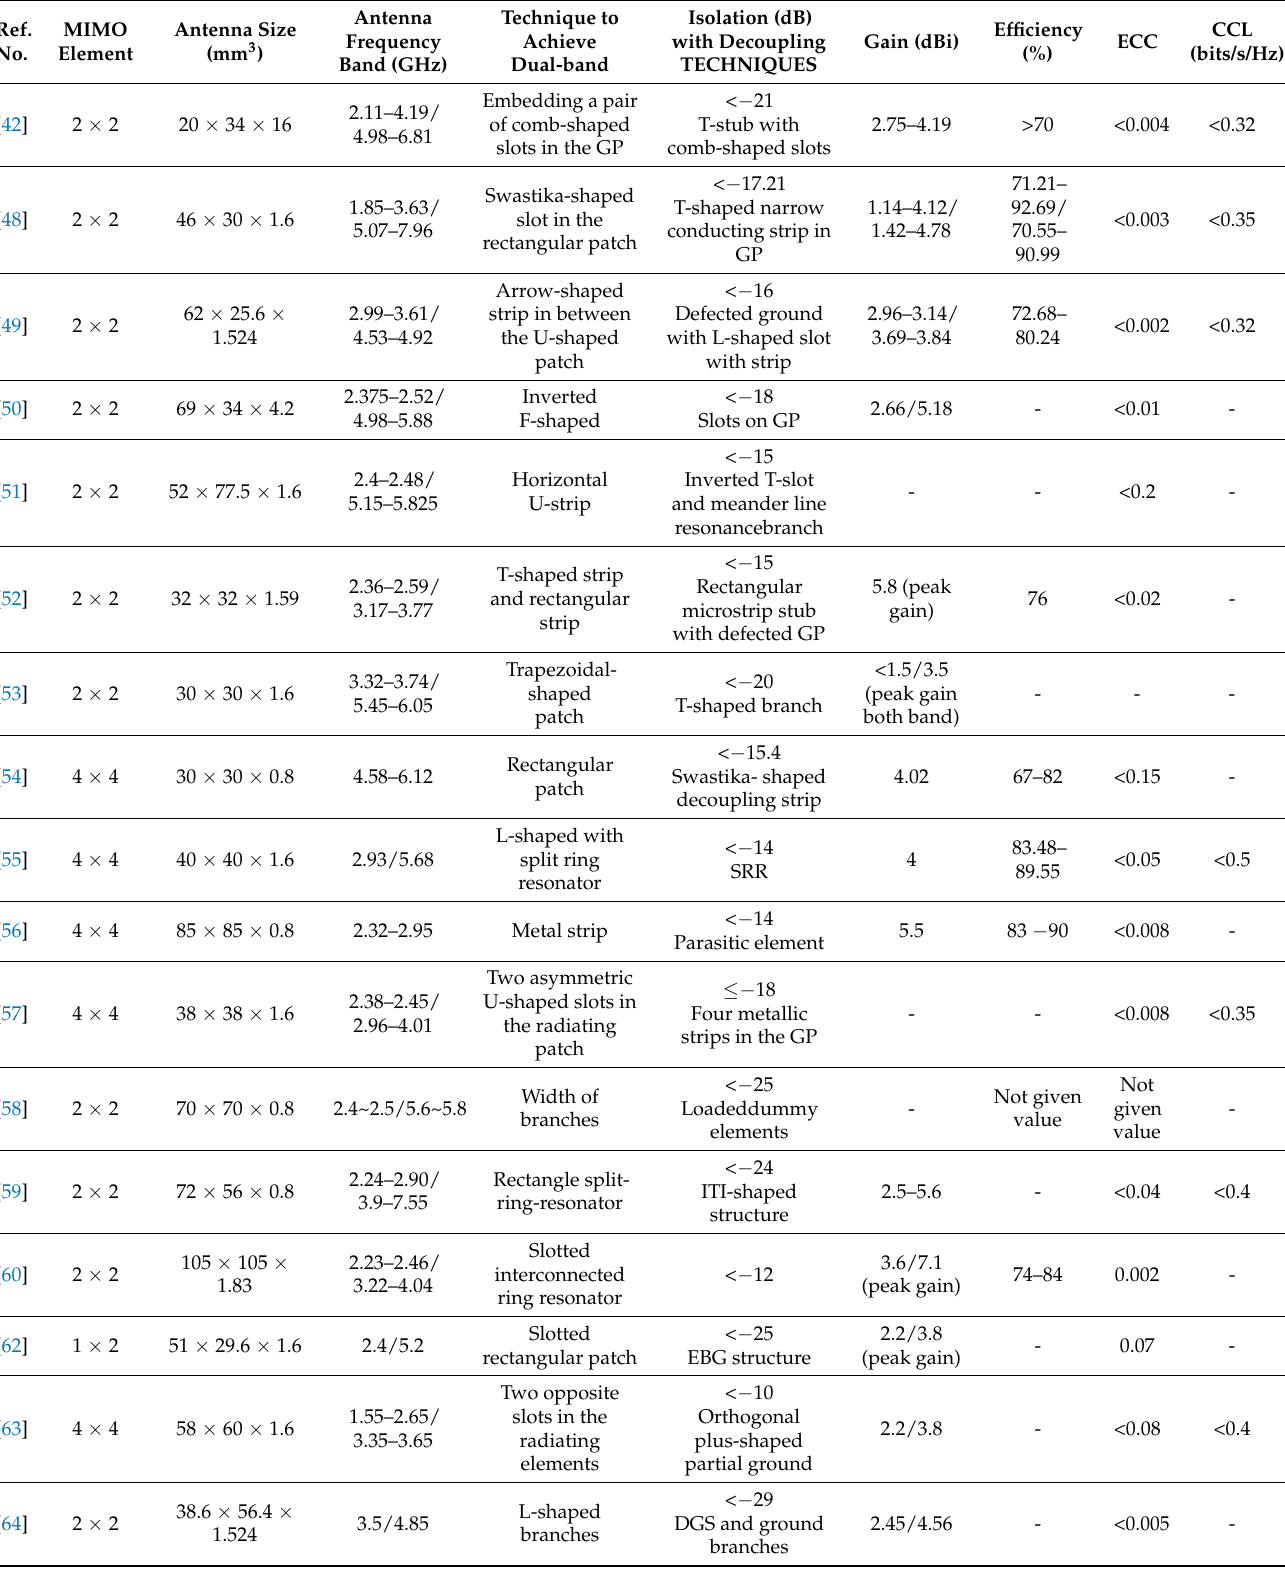
Table 2. Comparison of different dual-band MIMO